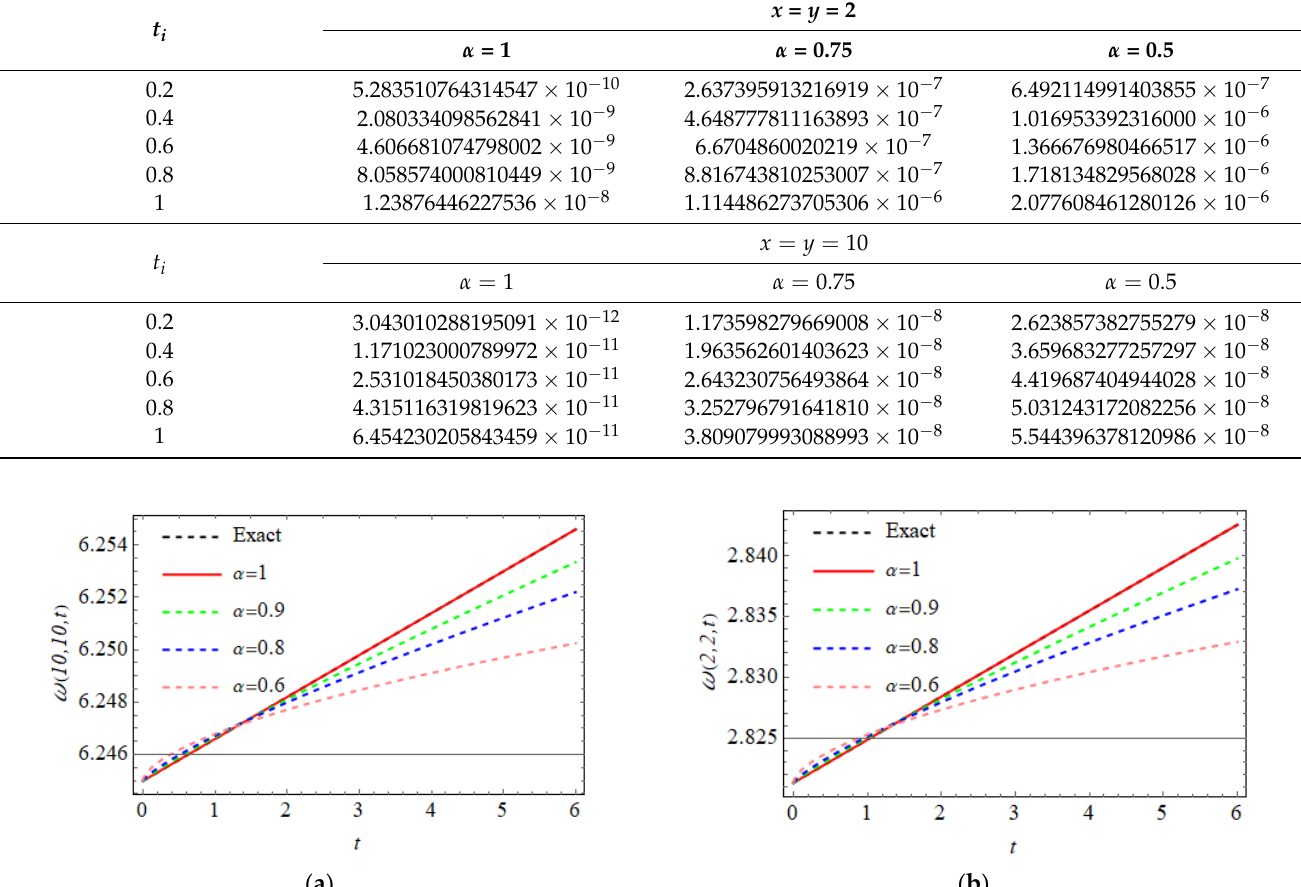
Figure 6. Profile exact and 3rd FSS solutions for nonlinear time-FGBPM (42) at various values of α for all t ∈ [ 0,6 ] . ( a ) For x = y = 10, ( b ) For x = y =